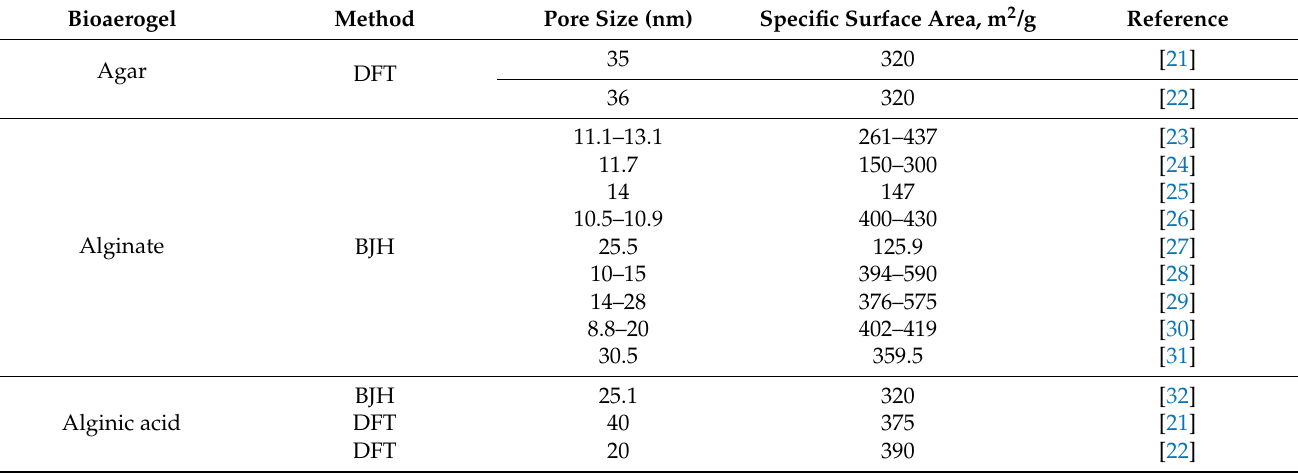
Table 1. Reported pore size or pore size distribution of some bioaerogels, obtained by gas sorption analysis.